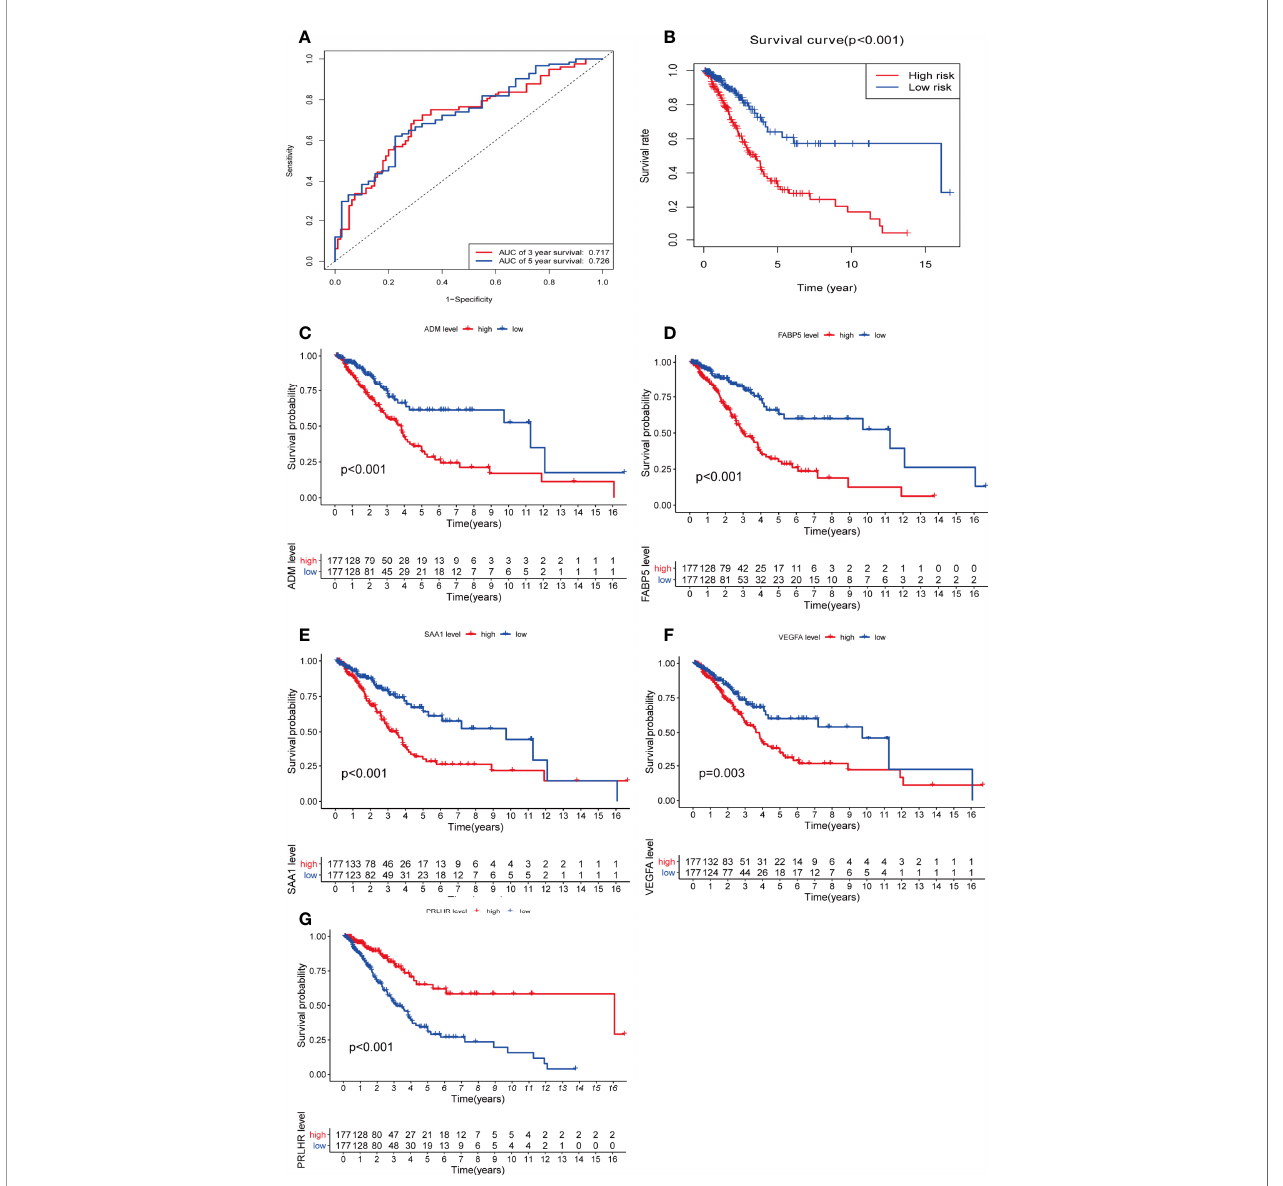
FIGURE 5 | There is a signi fi cant difference in overall survival rate among glioma patients when assessed with the fi ve DEmRNAs. (A) Time-dependent receiver operating character curve of the prognosis model constructed using 5-DEmRNA. (B) Overall survival rate of two groups of patients. (C – G) Kaplan – Meier analysis estimates of the overall survival rate using the 5-DEmRNAs in both groups of patients. red, high risk; blue, low